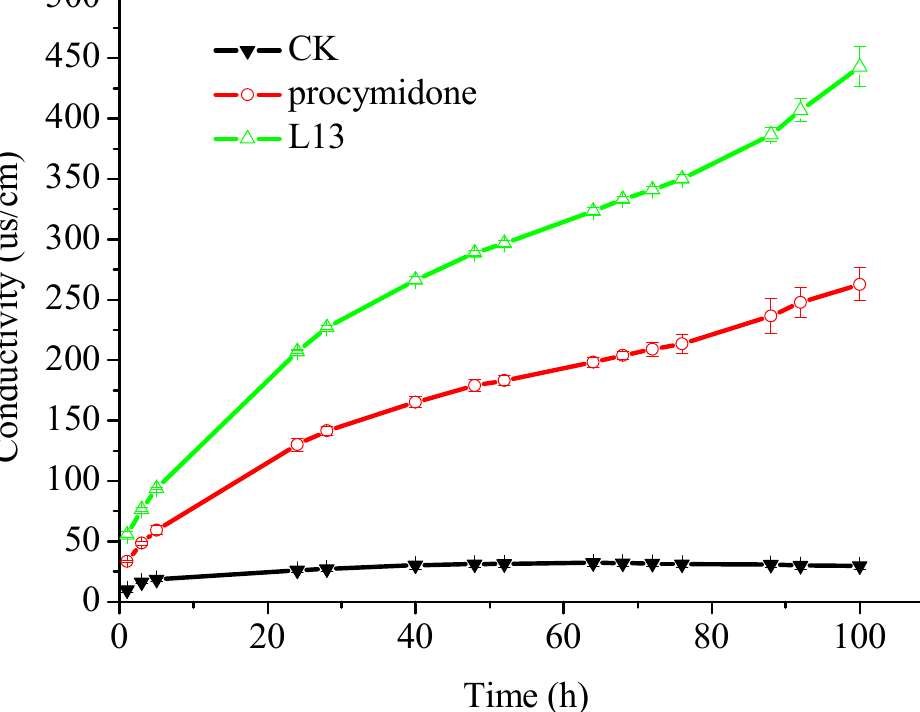
Figure 8. Electrolyte leakage from B. cinerea suspensions during different time exposure to different fungicides.